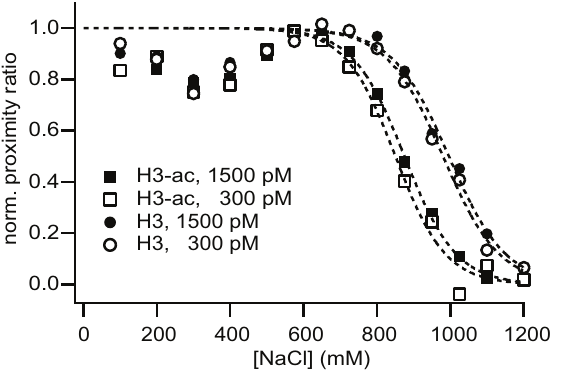
Figure 4. Acetylation of histone H3 decreases nucleosome stability. Salt-dependent proximity ratio at 1.5 nM and 300 pM nucleosome concentration measured with m psFRET. A loss in P is interpreted as nucleosome dissociation. Salt titration curves were approximated by a sigmoidal function and nucleosome stability was quantified in terms of the c 1/2 value, the salt concentration at which P is half the maximum observed around 500–600 mM NaCl. Measured c 1/2 values were (995 6 20) mM and (980 6 15) mM for 1.5 nM and 300 pM non-acetylated nucleosomes, while measured c 1/2 -values were 120 2 130 mM lower for H3-acetylated nucleosomes ((875 6 10) mM and (850 6 20) mM for 1.5 nM and 300 pM).